Question: What style of plot is this figure drawn as?
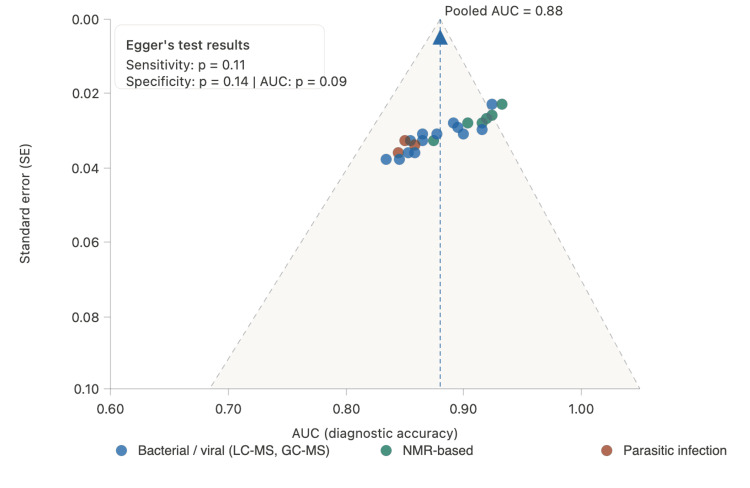
Answer: line